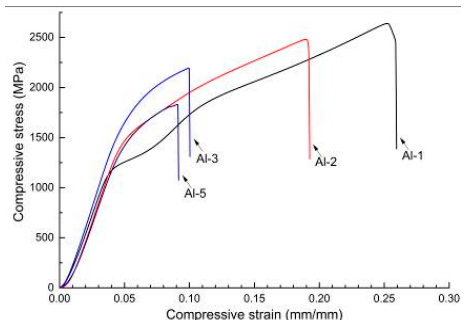
Figure 5. Stress–strain curves of alloys doped with Al.